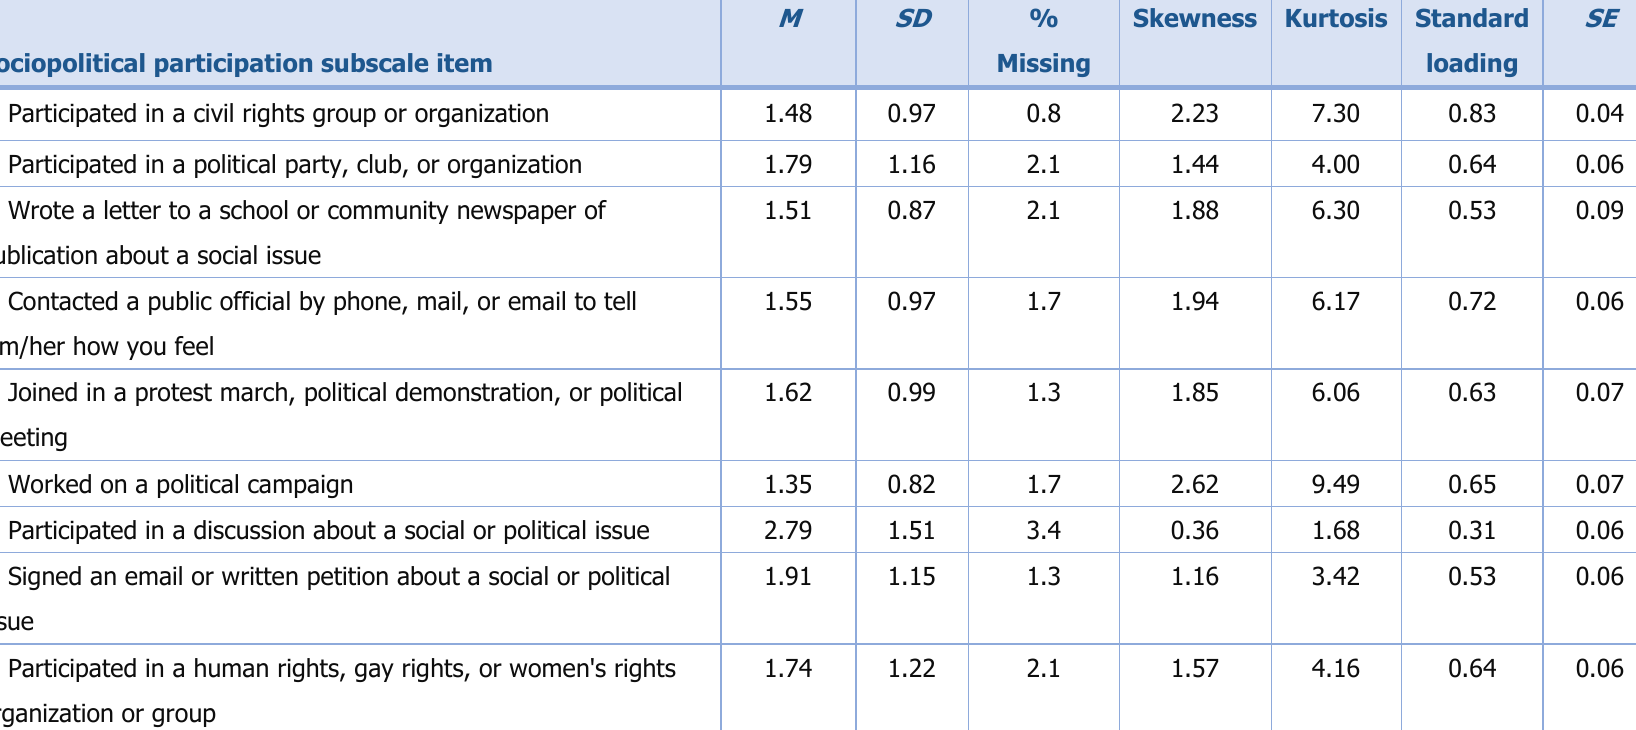
Table 1. Descriptive Statistics and Factor Loadings for Sociopolitical Participation Subscale